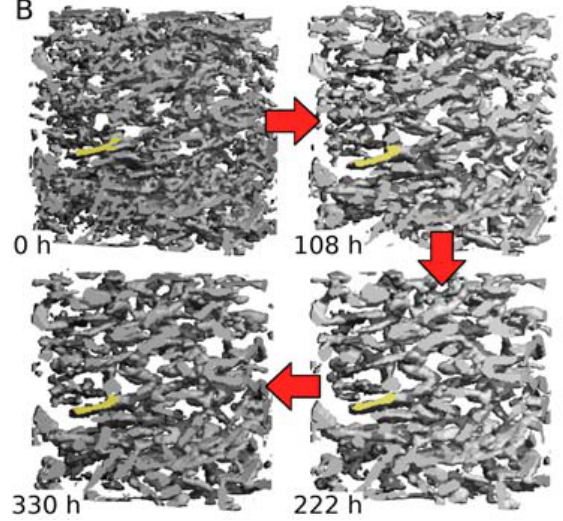
Fig. 2. Morphological evolution of snow during metamorphosis un-